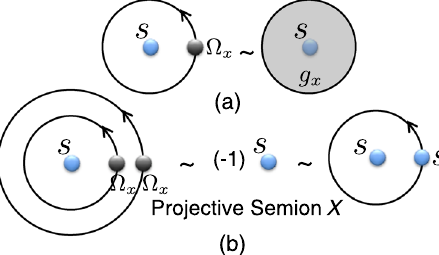
s derived from the sym- FIG. 2. The fusion rule Ω × Ω x x ¼ metry action on the semion in theory X [defined in Eq. (3)]. (a) Bringing a gauge flux Ω around the center semion is x equivalent to acting locally on it with the corresponding sym- metry g . (b) Bringing two Ω gauge fluxes around the center x x semion gives rise to a − 1 phase factor, because in theory X a semion carries half of the corresponding g charge. This − 1 can x be reproduced by bringing another semion around the center one, giving rise to the s on the right-hand side of the fusion